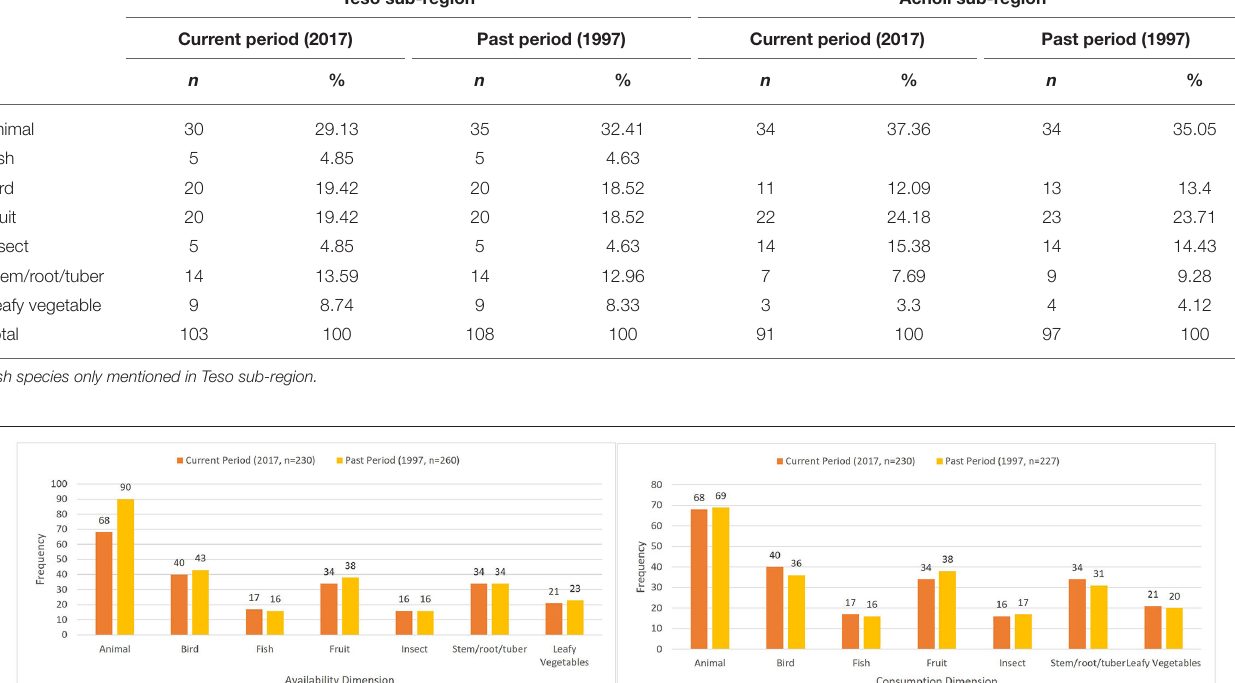
TABLE 2 | Collected wild food according to species in the past and current period in the Teso and Acholi sub-region. Teso sub-region